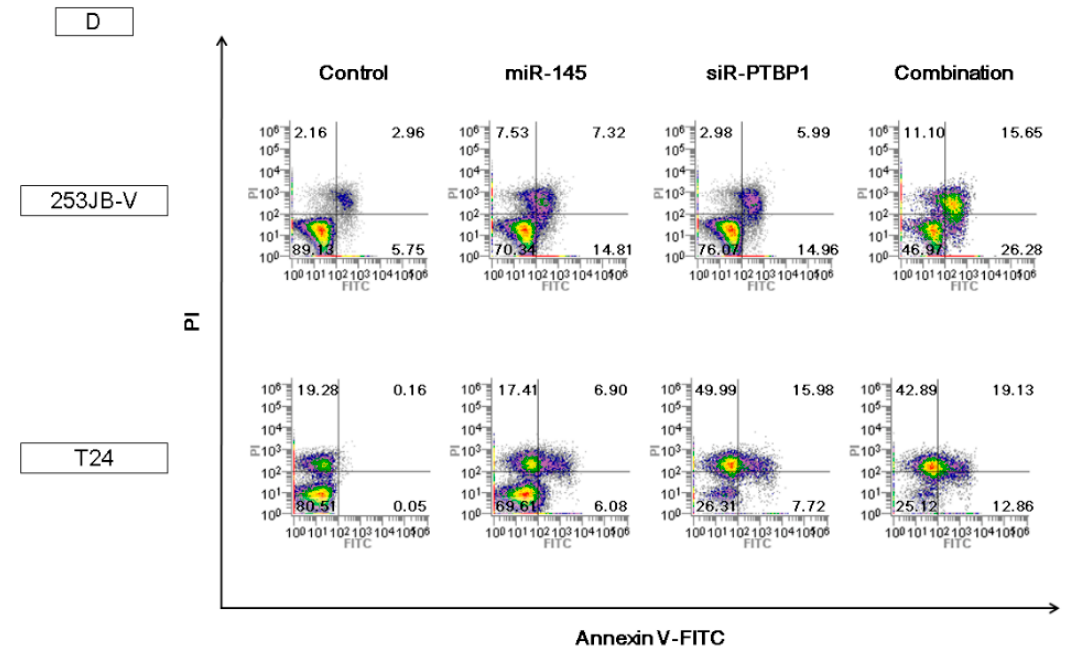
Figure 2. Ectopic expression of miR-145-induced apoptosis in bladder cancer cells. ( A , B ) Treatment with antagomiR-145 reversed the growth inhibition and the increased levels of cleaved form of poly (ADP-ribose) polymerase (PARP) elicited by miR-145 in 253JB-V cells; ( C ) Hoechst 33342 staining showed the typical apoptotic features, such as condensed chromatin and nuclear fragmentation indicated by the red arrows, in the miR-145-treated 253JB-V cells; ( D ) Annexin V and propidium iodide (PI) staining evaluated by flow cytometry indicated that combination treatment of miR-145 and siR-PTBP1 induced the apoptosis in 253JB-V and T24 cells compared with control and each single treatment. FITC: fluorescein isothiocyanate. ** indicates p < 0.01; *** p < 0.001. NS: not significant.